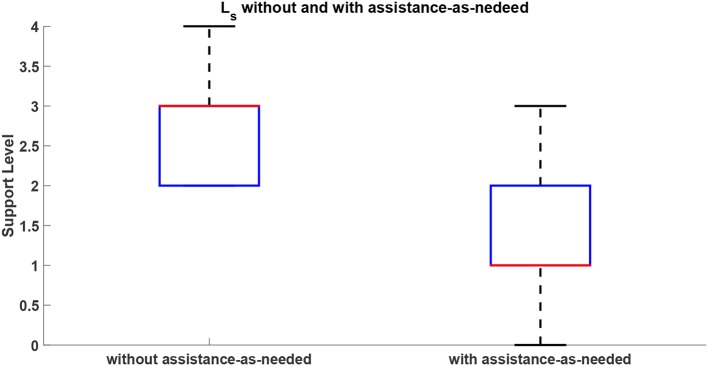
Ls without and with assistance-as-needed.